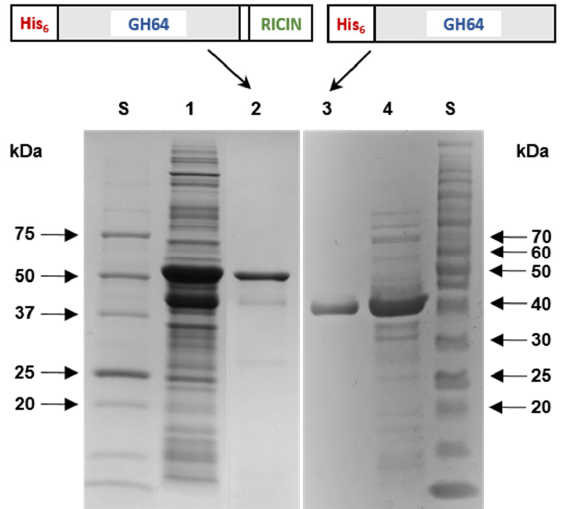
Figure 3. SDS-PAGE of the purified rGluY and rGluY ∆ RICIN after affinity chromatography on HisTrap HP. Lane S, standard marker proteins; lane 1, the whole cell lysate of rGluY-expressing E. coli BL21 after IPTG induction; lane 2, purified rGluY; lane 3, purified rGluY ∆ RICIN; lane 4, the soluble cell lysate of rGluY ∆ RICIN-expressing E. coli BL21 after IPTG induction. Table 1. Enzymatic features of bacterial GH64 endo- β -1,3-glucanases active for β -1,3- D -glucans. Strain